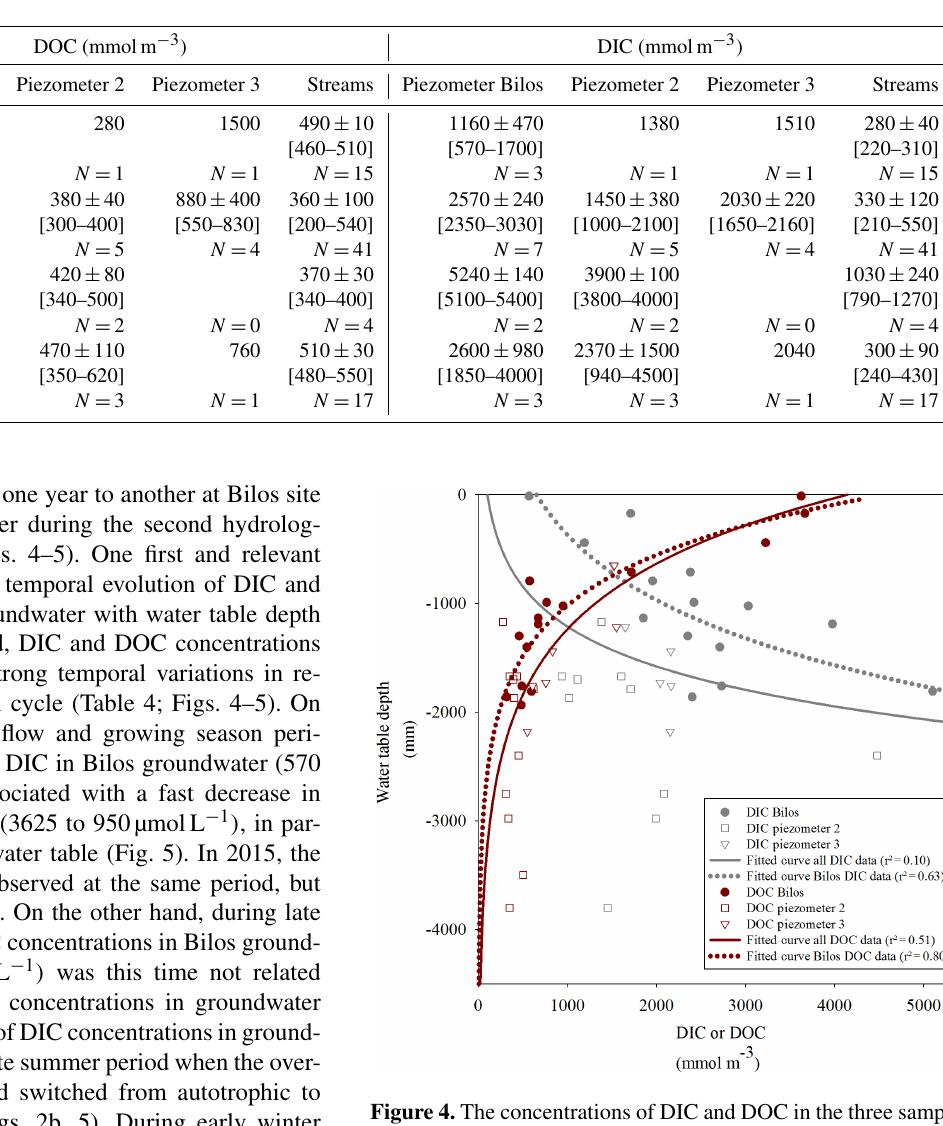
Table 4. Carbon concentrations in the sampled groundwater and in the sampled first-order streams during the sampling period (January 2014– July 2015) for high-flow (January–March 2014 and February–March 2015), growing season (April–August 2014 and April–August 2015), December 2015) periods. Numbers represent the mean ± SD, the range (between square brackets) and the number ( N ) of samples for each hydrological period.